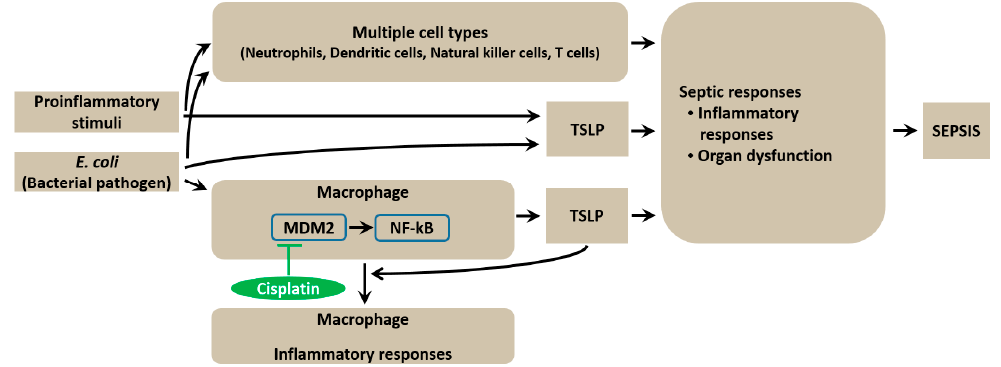
Figure 7. Graphical abstract of TSLP function during sepsis. Production of TSLP is induced via the MDM2/NF- κ B signaling pathway in E. coli -stimulated macrophages. TSLP affects inflammatory cytokines production and organ dysfunction during sepsis. Cisplatin protects mice against lethal sepsis by inhibiting the series of reactions. TSLP can be induced directly by E. coli or other proinflammatory stimuli. Multiple cell types such as neutrophils, dendritic cells, natural killer cells, and T cells might be involved in sepsis.